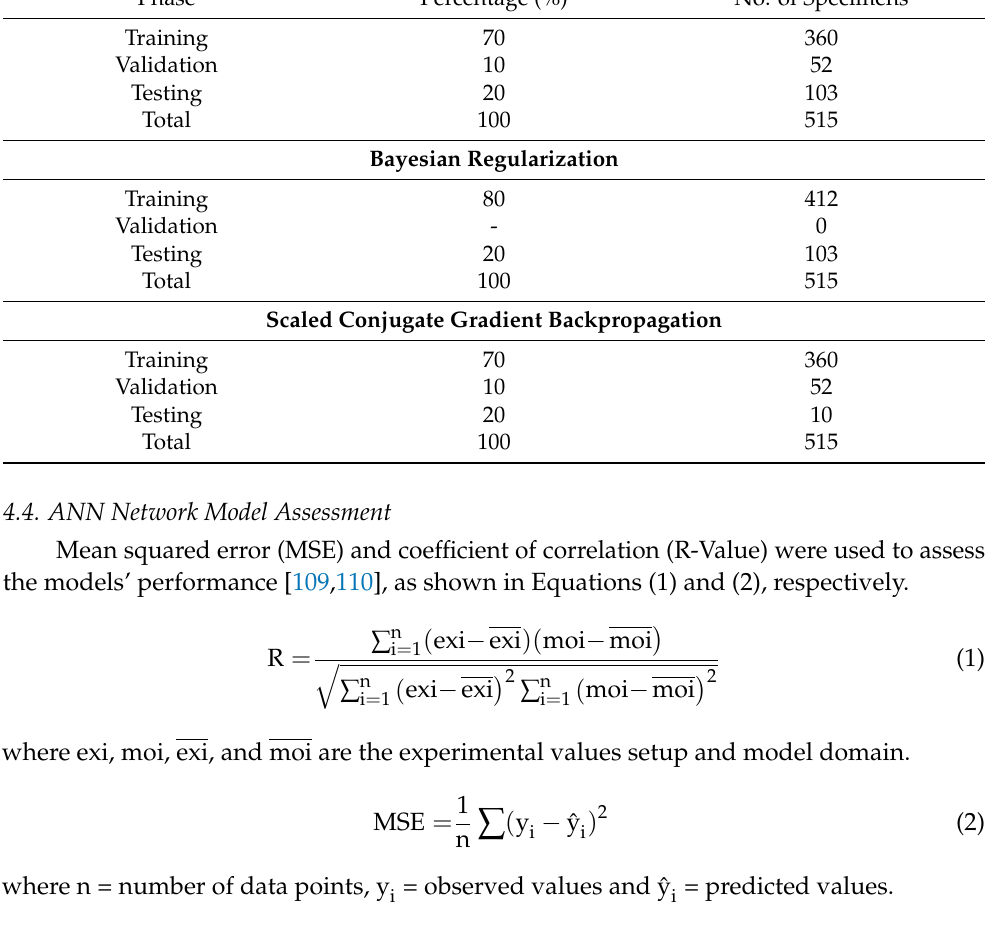
Table 3. Data splitting for model’s training, validation, and testing. Levenberg–Marquardt